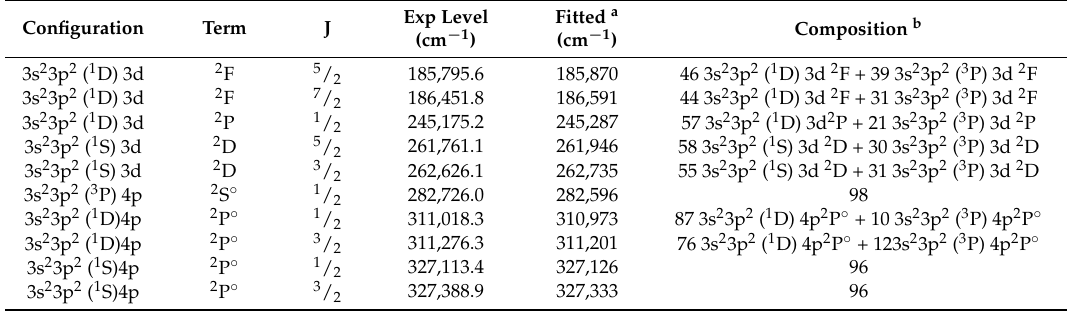
Table 2. New Ar IV energy levels.